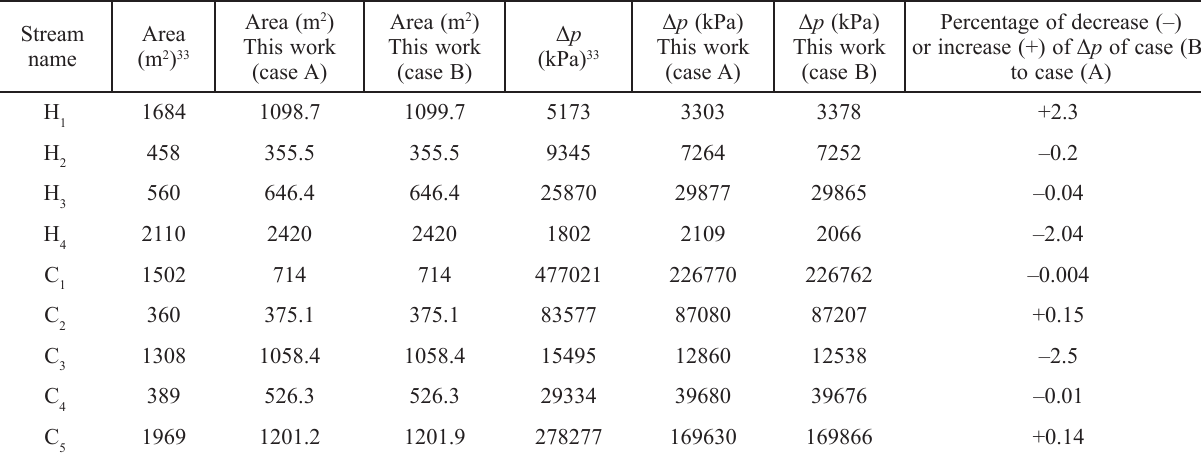
Table 5 – Area and pressure drop comparison for case study